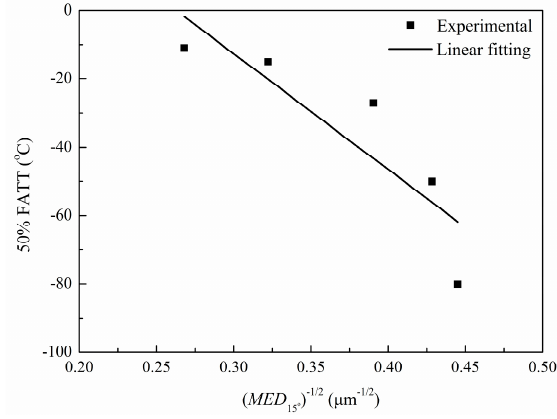
Figure 16. The effective grain size of the simulated CGHAZ at different heat input.